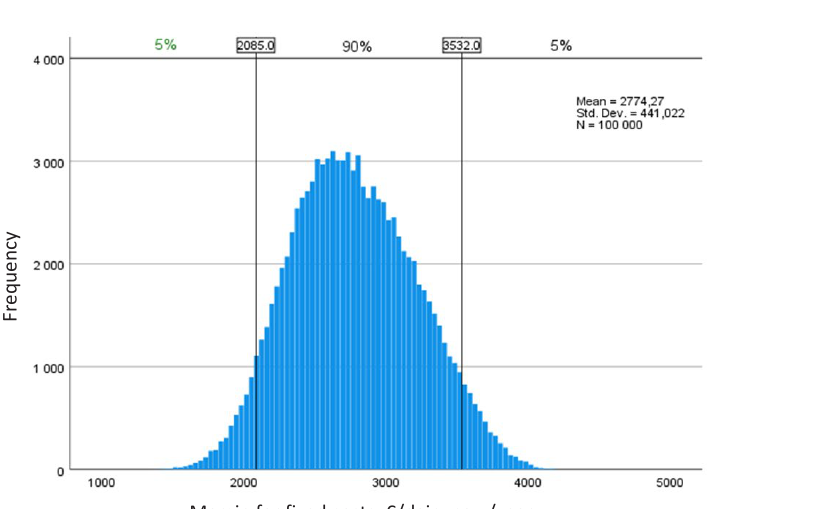
Margin for fixed costs, €/dairy Fig. 2. Distribution of margin for fixed costs in herds with 120 dairy cows, automatic milking system, and blanket dry cow therapy (probability of post-calving intramammary infection 0.18).